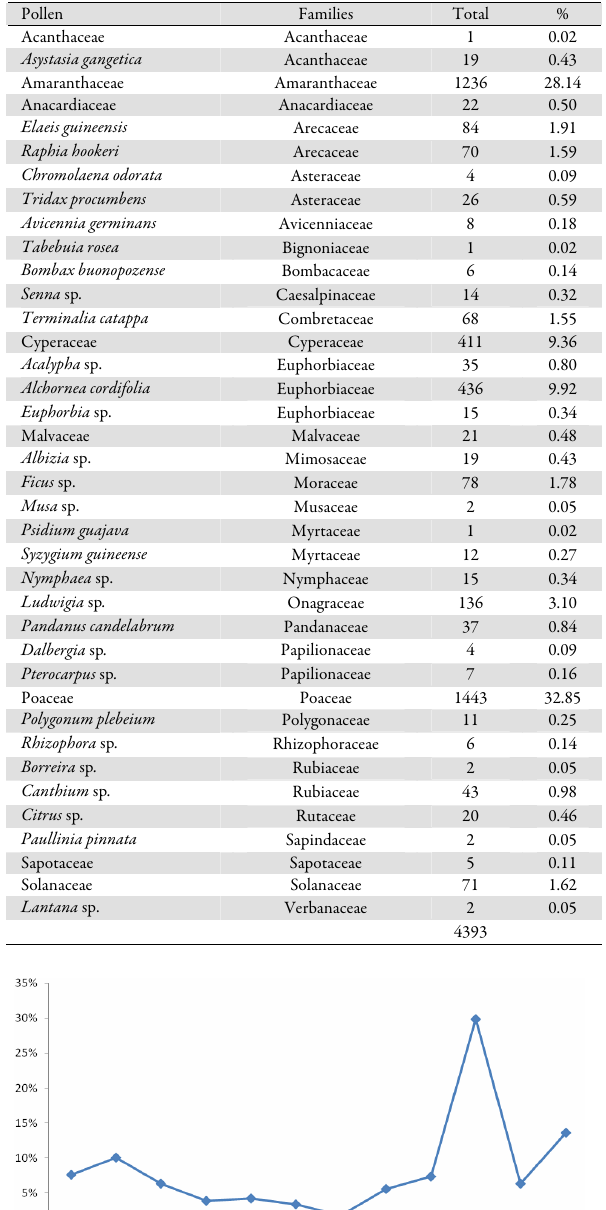
Tab. 1. Airborne pollen of Shomolu Local Government